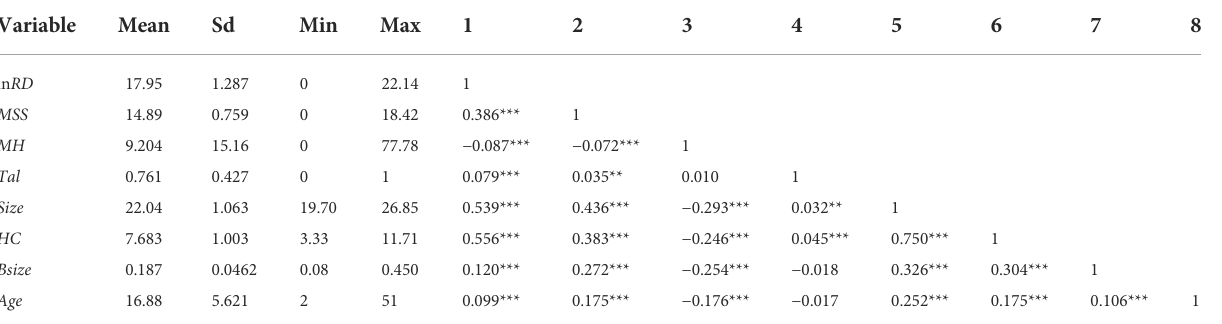
TABLE 2 Descriptive statistics and correlation coef fi cients of core